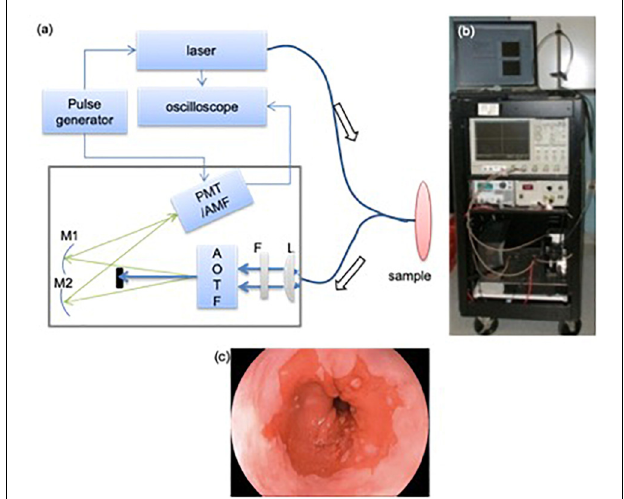
FIGURE 1 | TRF instrument used for the clinical study (a) : A schematic and picture of TRF spectroscopy system. A bifurcated fiber optics probe was used to collect signal. AOTF: acousto-optical tunable filter; L: plano-convex lens; F: long-pass filter (cut-off at 360 nm); M1/M2: mirrors; PMT: micro-channel plate photo-multiplier tube; AMF: amplifier. Bottom: endoscopic image showing the extent of the BE region. (b) A photograph of the optical biopsy system. (c) A representative endoscopic image of the